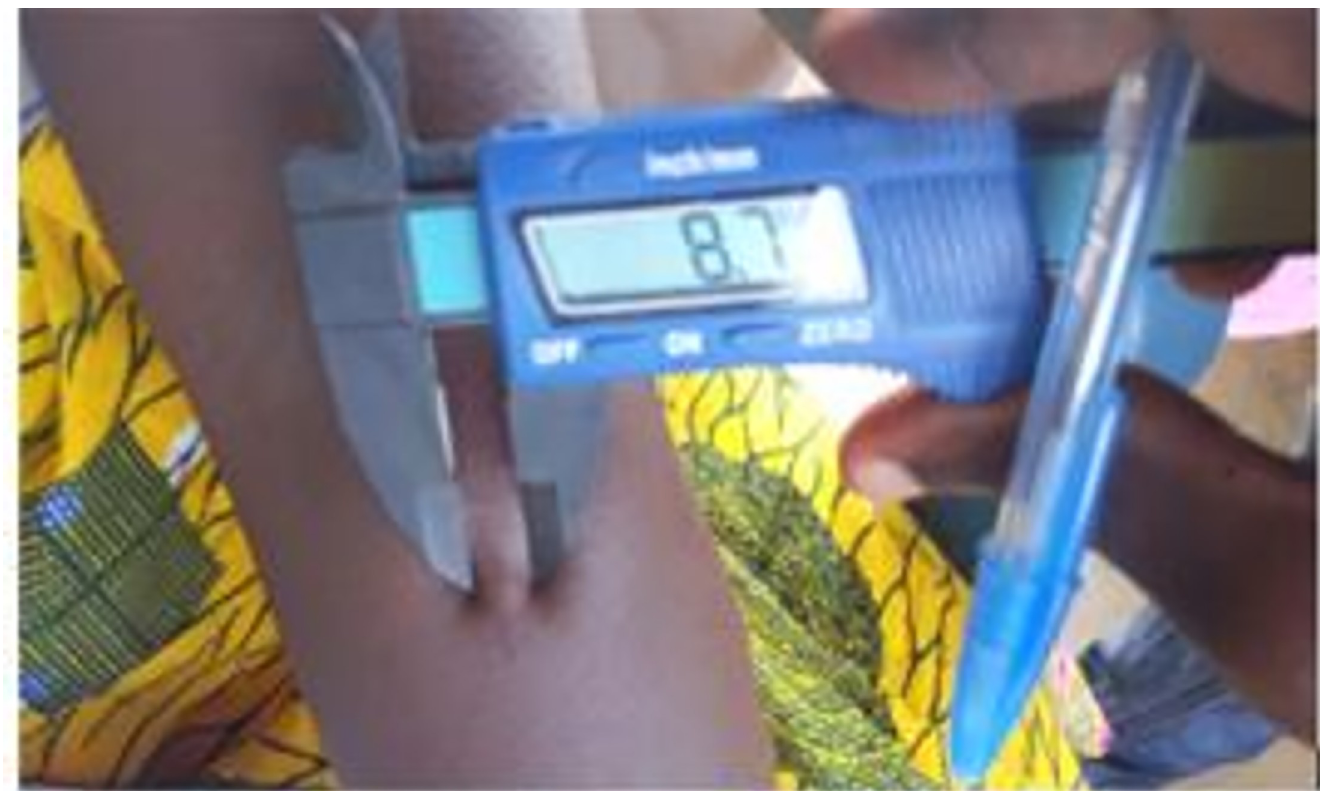
Fig 1. Induration on skin 48–72 hours after LST placement and measurement.